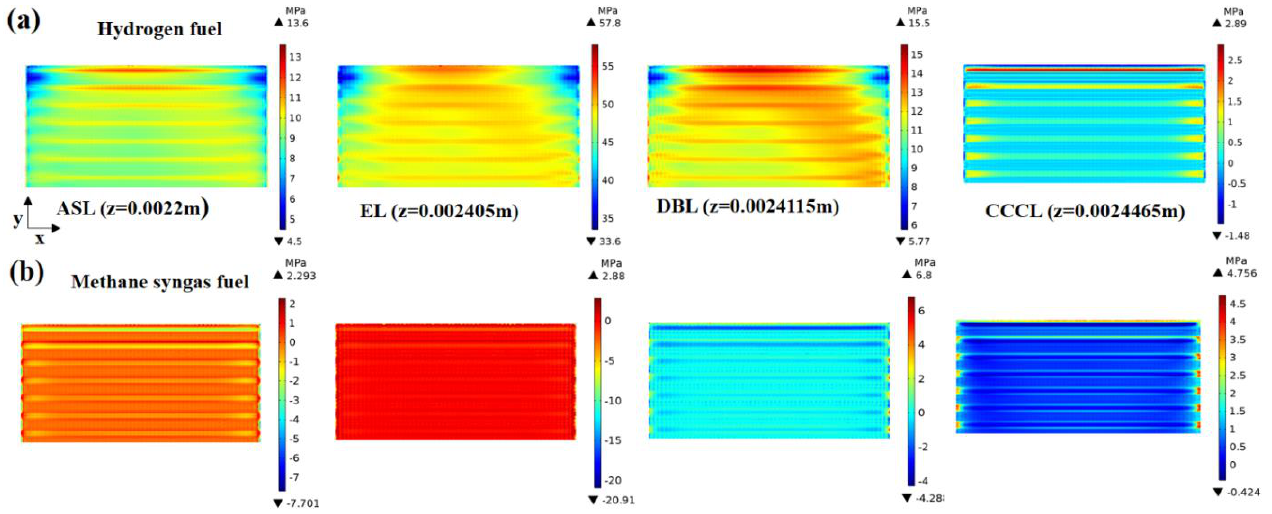
Figure 8. Thermal stress in the middle section of each electrode layer of the PEN for: ( a ) hydrogen fuel; ( b ) methane syngas fuel.